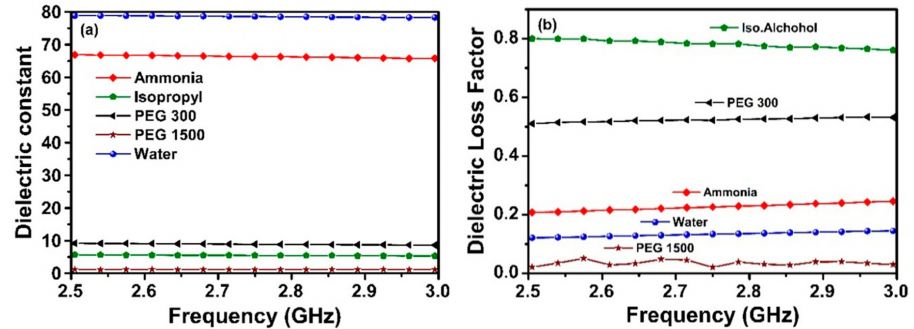
Figure 12. Measured results for di ff erent samples: ( a ) dielectric constant; ( b ) dielectric loss factor.